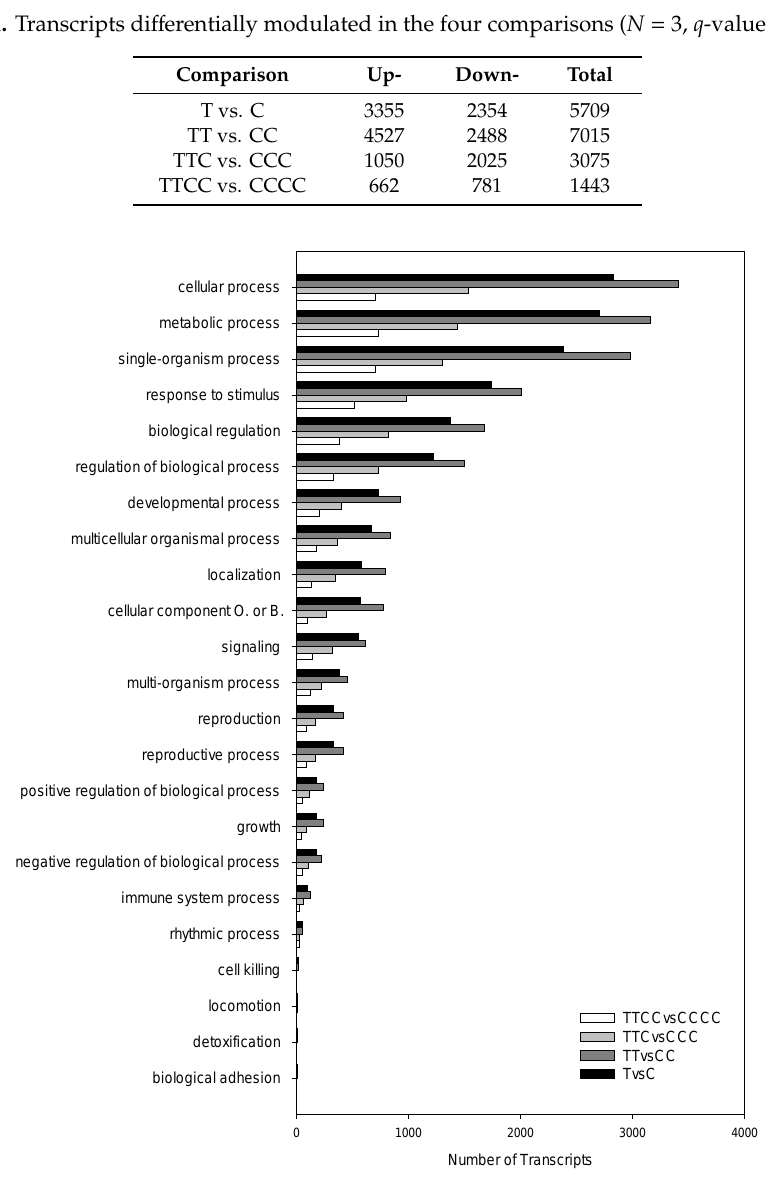
Table 1. Transcripts di ff erentially modulated in the four comparisons ( N = 3, q -value < 0.05).